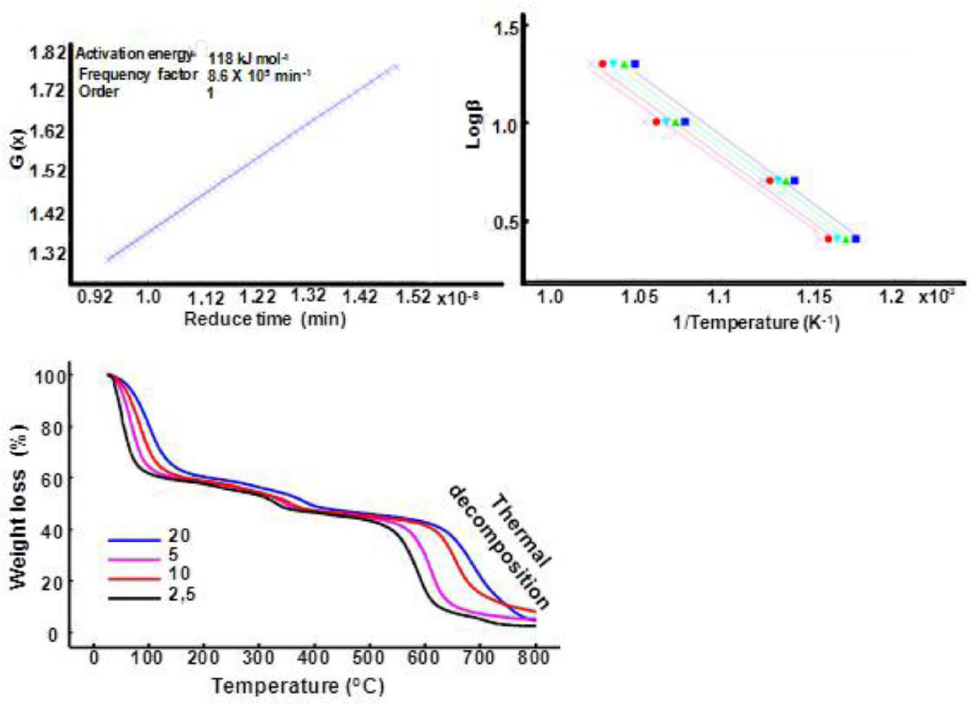
FIGURE 8 - TG curves obtained in a dynamic air atmosphere (50 mL min –1 ) with β = 2.5, 5, 10 and 20 °C min –1 , and corresponding curves of log heating rate (logβ) as a function of inverse temperature (K –1 ) and the plot of G(X) against inverse temperature for the thermal decomposition step of phytic acid